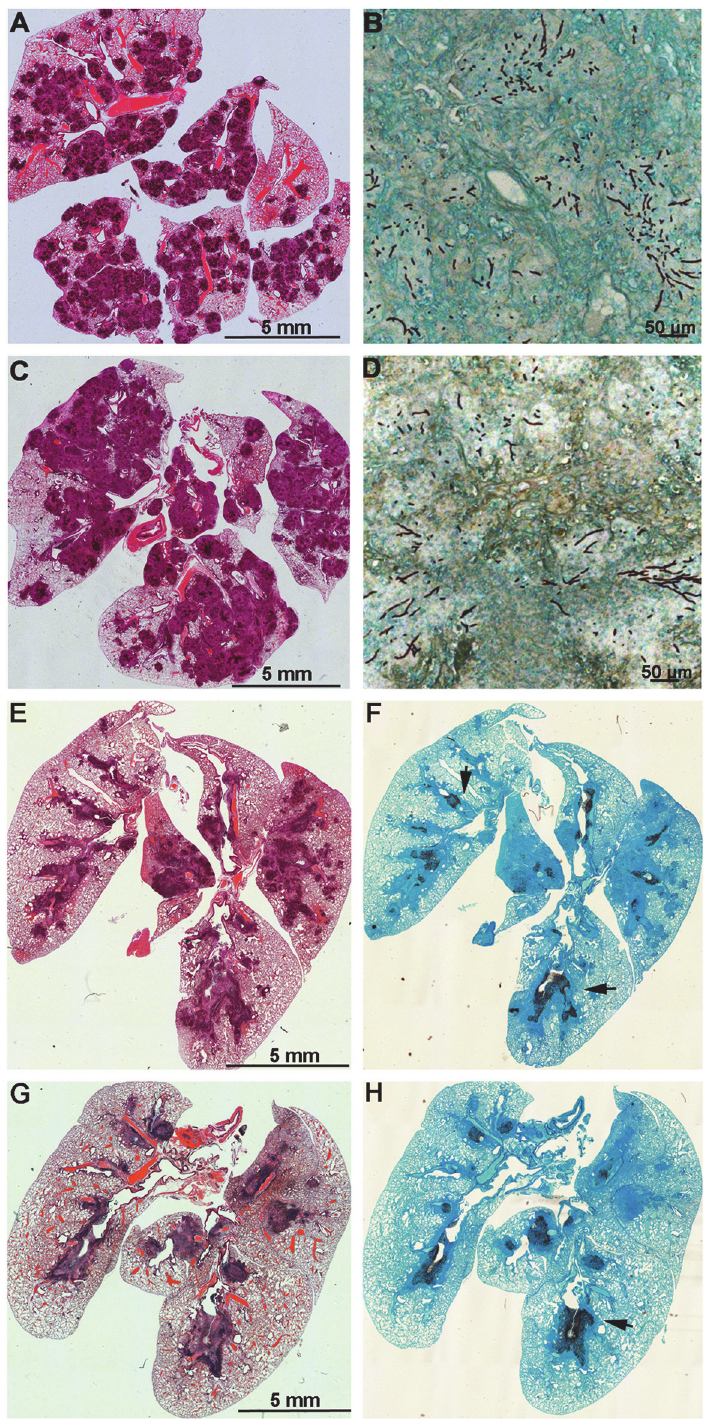
Fig 3. Lungs of mice with chronic granulomatous disease (CGD) or hydrocortisone-treated BALB/c mice inoculated with Aspergillus fumigatus isogenic strains, AFB62 and AFB62F9. (A-D) Lungs of CGD mice. (E-H) Lungs of hydrocortisone-treated BALB/c mice. (A, B, E and F) Lungs of mice inoculated with AFB62. (C, D, G and H) Lungs of mice inoculated with AFB62F9. Numerous granulomas (A and C) with extensive hyphal growth (B and D) are seen in the lungs of CGD mice at nine days post fungal inoculation. Extensive hyphal growth (arrows in F and H) is seen in the bronchial tree in lungs of